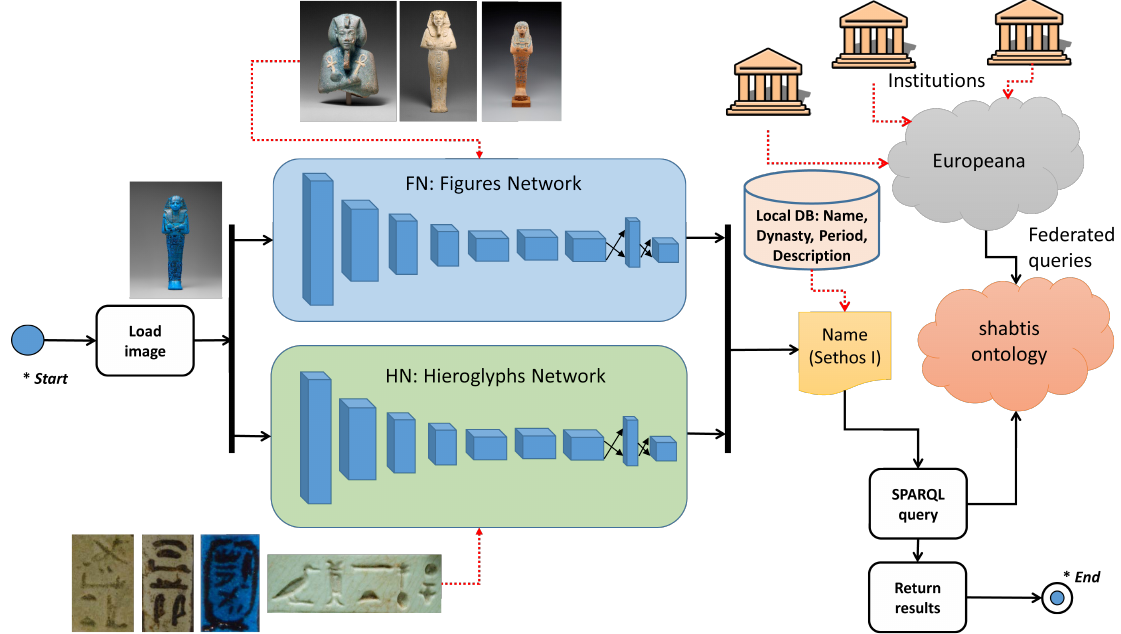
Figure 4. Schema of the system with some shabtis and names used for the training. Shabtis/Names from the MET (Metropolitan Museum of Art), New York, or Private